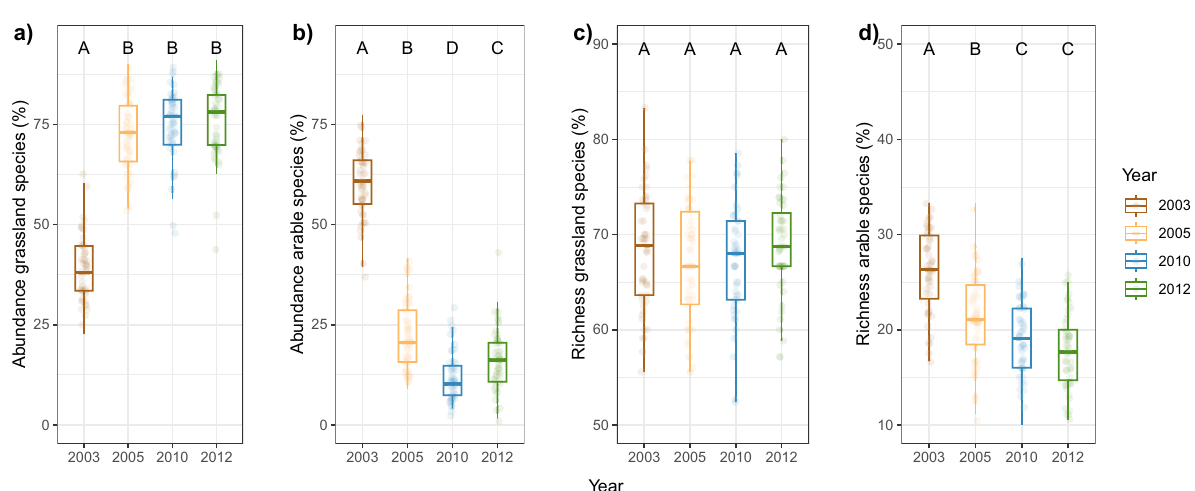
Figure 4. Percentage of ( a ), ( b ) abundance and ( c ), ( d ) species richness of carabid beetles assigned to grassland and arable land species at different years. Lines in boxes represent median, top and bottom of boxes represent first and third quartiles, and whiskers represent 1.5 interquartile range. Differences among the years are assessed based on estimated marginal means. Boxes with the same letters are not statistically different. Dots represent partial residuals for Year and Plant species richness. Please note the different scaling of the